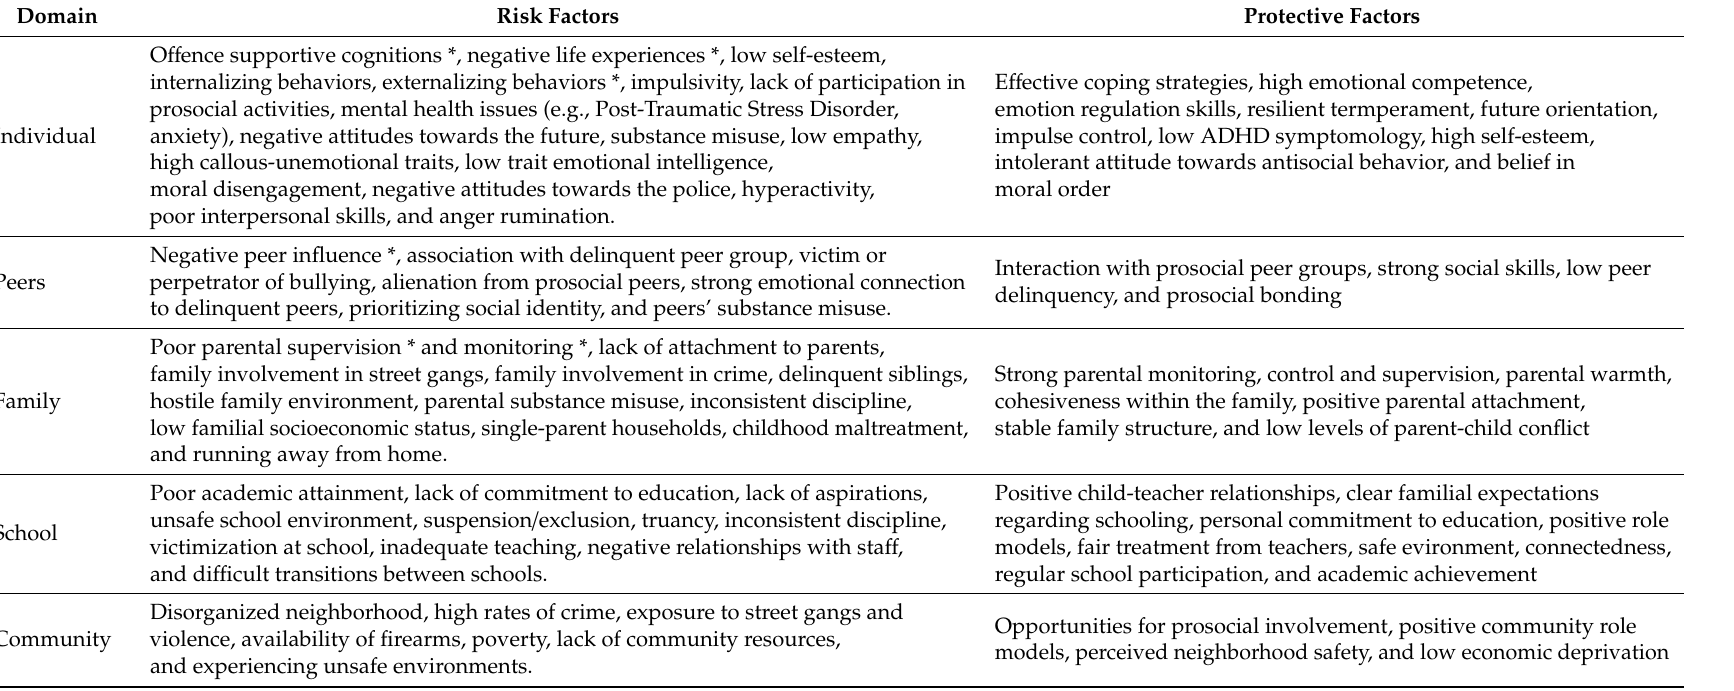
Table 1. Examples of risk factors for street gang membership, according to